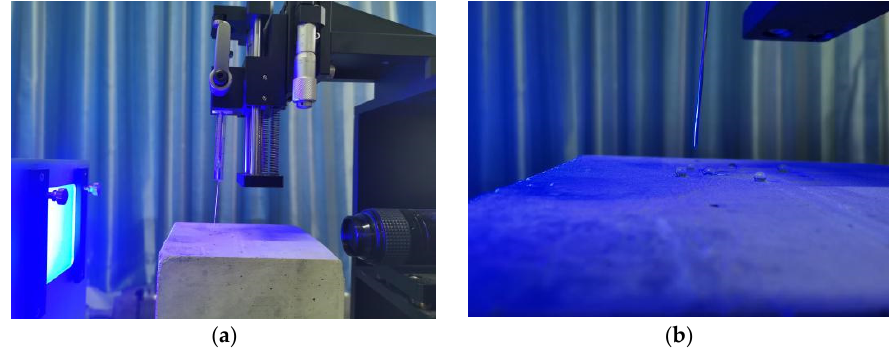
Figure 2. Contact angle test of the concrete: ( a ) test device; ( b ) test process.